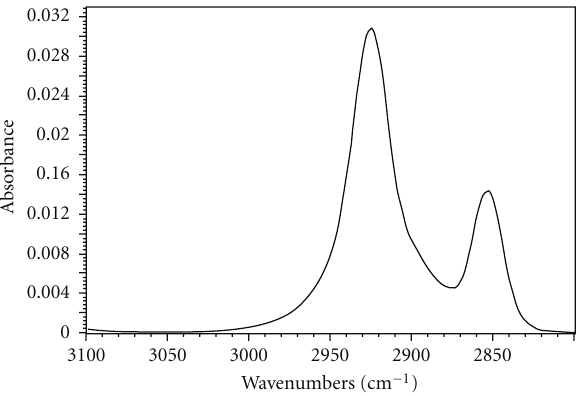
Figure 1: MER FTIR spectrum of the TNN monomolecular layer on a glass